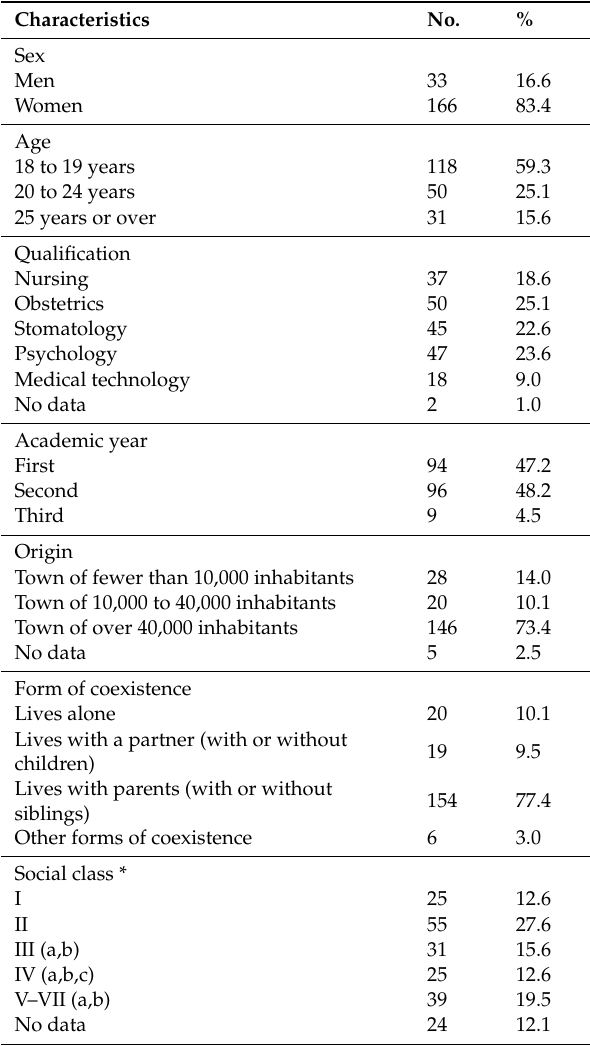
Table 1. Socio-demographic characteristics of the